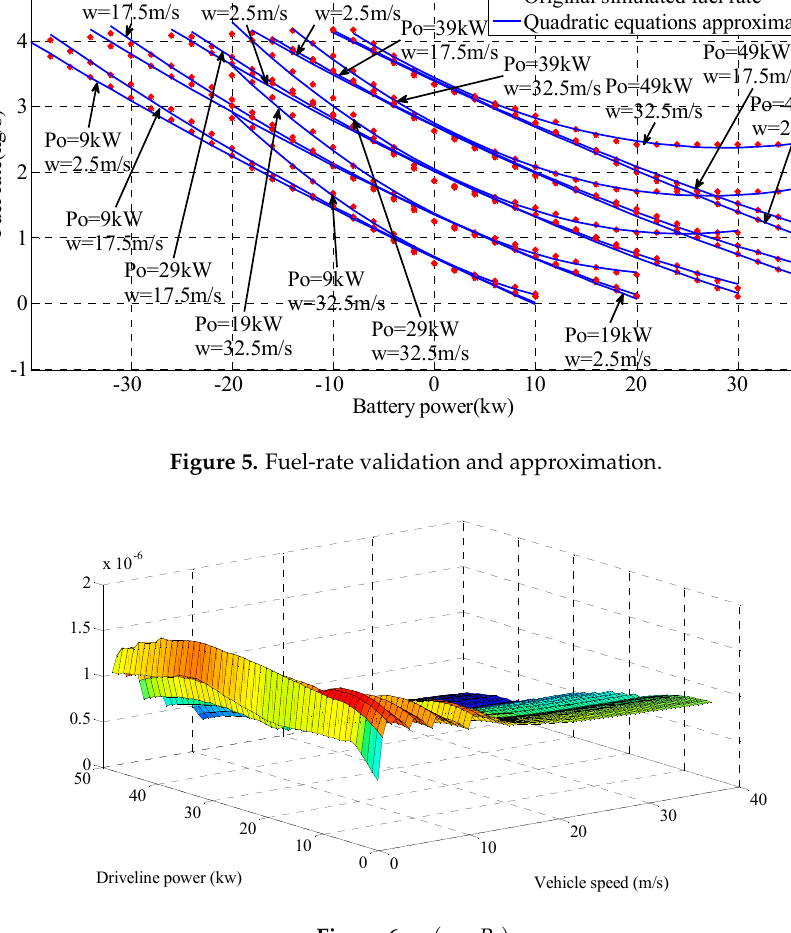
Figure 6. Figure 6. a 2 ( w 0 , P 0 )